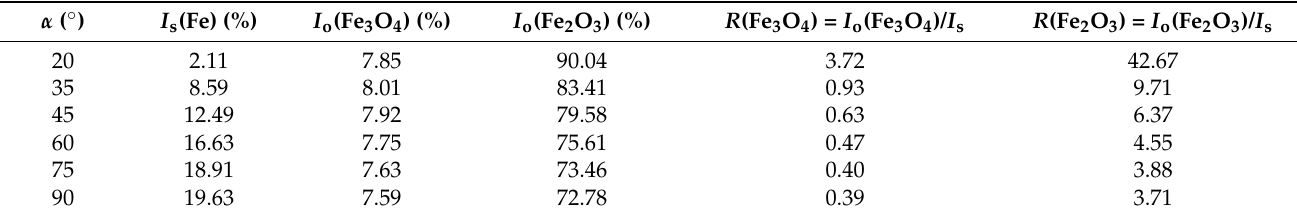
Table 4. The values of density, molecular weight , and kinetic energy for Fe, Fe 2 O 3 , and Fe 3 O 4 , as well as R ∞ for both iron oxides.